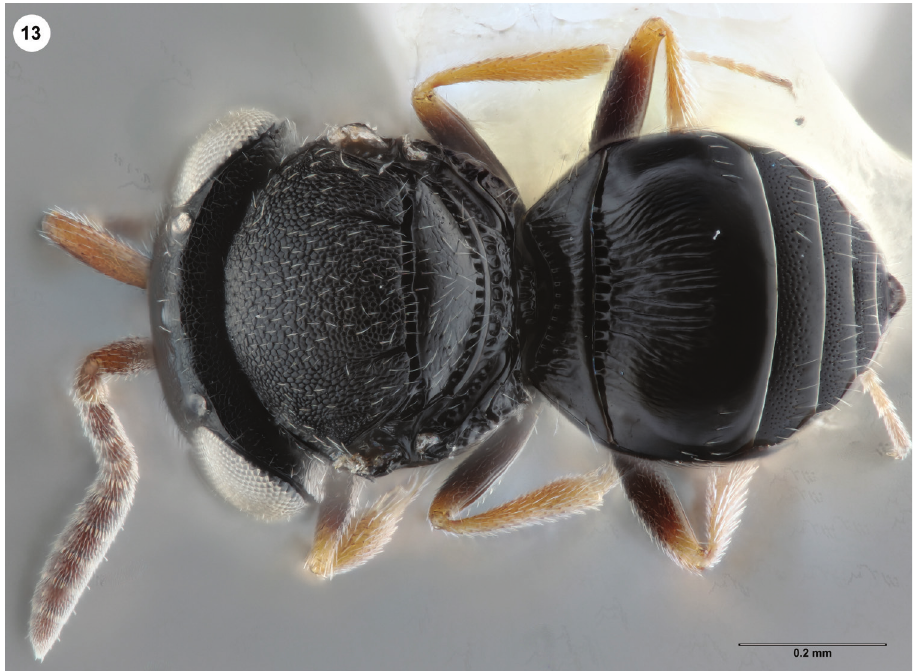
Figure 13. Trissolcus darreh , habitus, dorsal view (FSCA tion of posterior scutellar sulcus: present. Form of metascutellum: single row of foveae along anterior margin, rugulose posteriorly. Metanotal trough: foveate, foveae occupy- ing less than half of metanotal height. Metapostnotum: invaginated near lateral edge of metascutellum. Anteromedial portion of metasomal depression: smooth. Wings. Length of postmarginal vein: about 1.5 times as long as stigmal vein. Color of setae on fore wing: white throughout, brown at distal end. Legs. Color of legs: coxae and femora dark brown to black, otherwise pale brown to yellow. Anteroventral area of hind femora: not covered by setae. Metasoma. Width of metasoma: about equal to width of mesosoma. Number of sublateral setae (on one side): 0. Setation of laterotergite 1: absent. Length of striation on T2: extending two-thirds the length of the tergite. Setation of T2: present only in posterolateral corner. Setation of laterotergite 2: present.